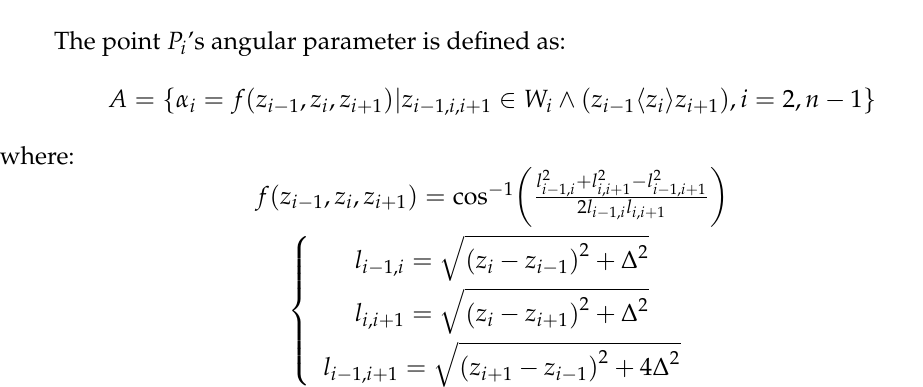
Figure 6. X-zero method, cylindrical coordinate system, single channel (ring).